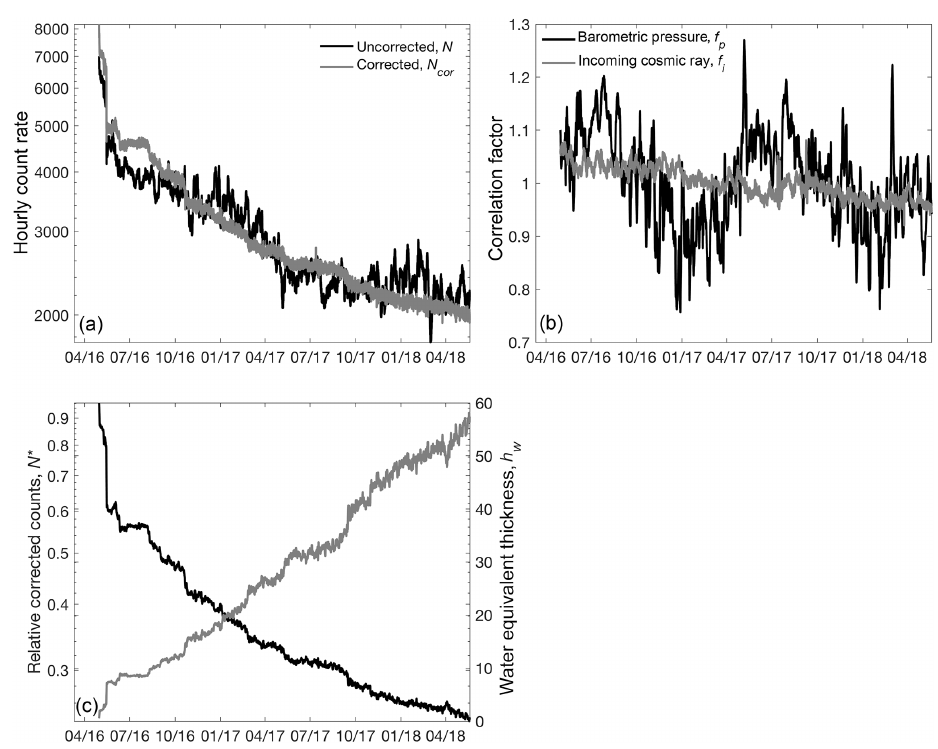
Figure 3. (a) (black) Uncorrected, N , and (grey) corrected, N cor , hourly neutron count rate measured at Summit Camp, Greenland, by a cosmic ray neutron sensor (CRNS) emplaced in the firn. (b) Count rate correction factors for (black) atmospheric pressure, f p , and (grey) solar activity, f i , as derived from Eqs. (1) and (2) in Sect. 3 of the text and the Thule (THUL) neutron monitor for reference. (c) (black) Relative corrected counts, N ∗ , and resulting (grey) water-equivalent thickness, h w , from Eqs. (4) and (5) and the parameters in Table 1.